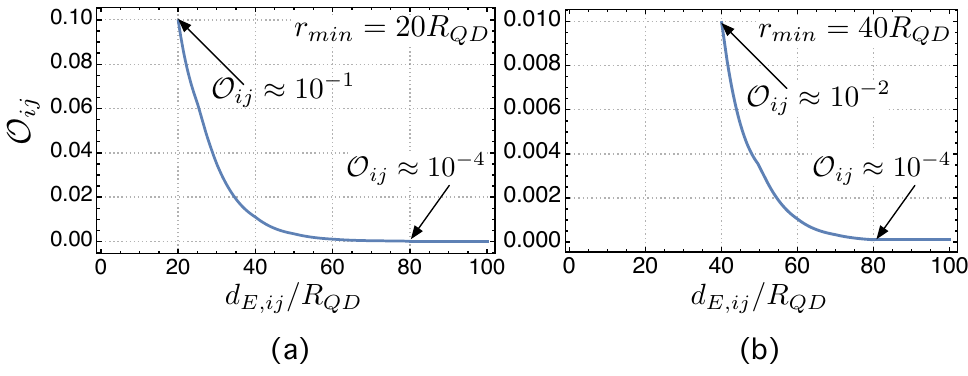
Figure 3. ( a ) Mean value of the overlap as a function of the normalized inter-dot distance d E , ij / R QD in the case in which r min = 20 R QD . ( b ) Mean value of the overlap as a function of d E , ij / R QD in the case in which r min = 40 R QD